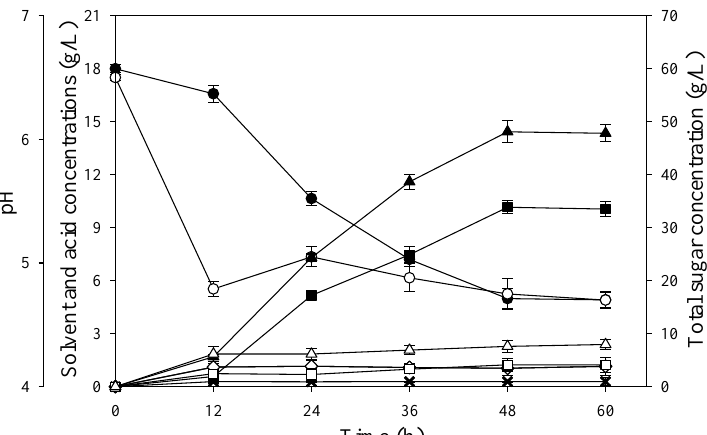
Figure 4. Butanol fermentation profiles from SSJ medium supplemented with urea 4X (0.64 g/L) by free cells of C. beijerinckii TISTR 1461: acetone ( ♦ ), butanol ( ■ ), ethanol (×), ABE ( ▲ ), acetic acid ( ◊ ), butyric acid ( □ ), total acid ( Δ ), pH ( ○ ), total sugars (●). Table 5. Batch butanol fermentation efficiency levels from SSJ medium supplemented with urea at various concentrations at 48 h of fermentation.